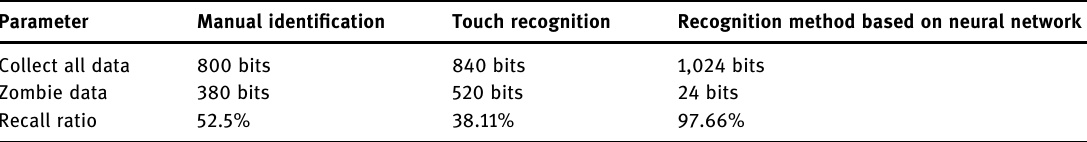
Table 1: Recall rate of data identi fi cation by di ff erent methods